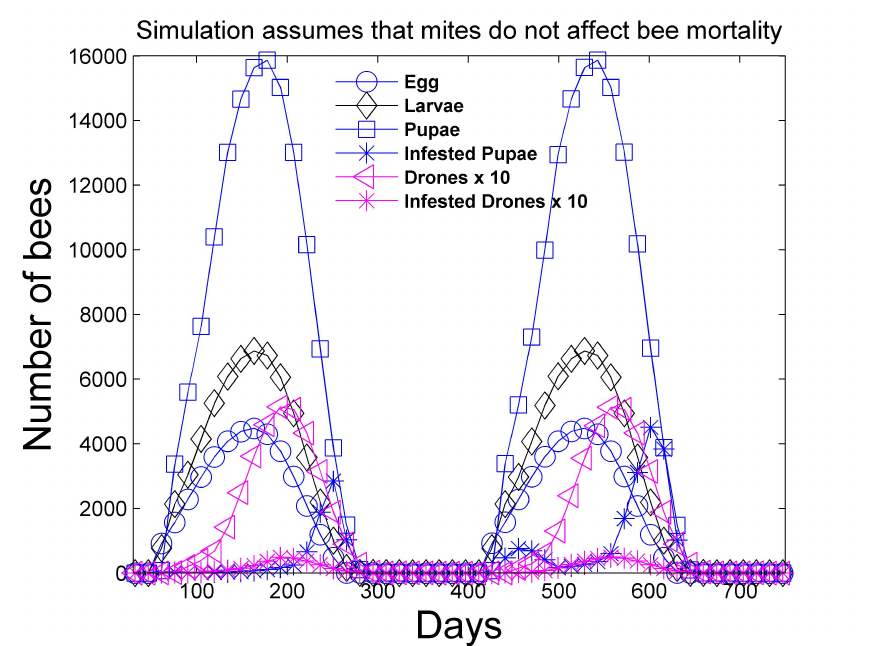
Figure 1. Two-year simulation of a honey bee colony with mites using the simulation parameters in Tables 4 and 5. The number of eggs, larvae, total pupae, infested pupae, total drones, and infested drones is shown. Mites do not affect the survival rate of any bee caste in this simulation. The number of drones is multiplied by 10 for plotting purposes.